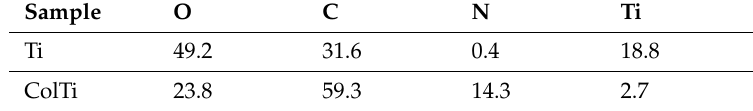
Table 1. Surface composition, as detected by X-ray Photoelectron Spectroscopy (XPS), of Ti and ColTi samples (data are expressed as % at.) and suggests that the thickness of the coating is very thin. Sample O